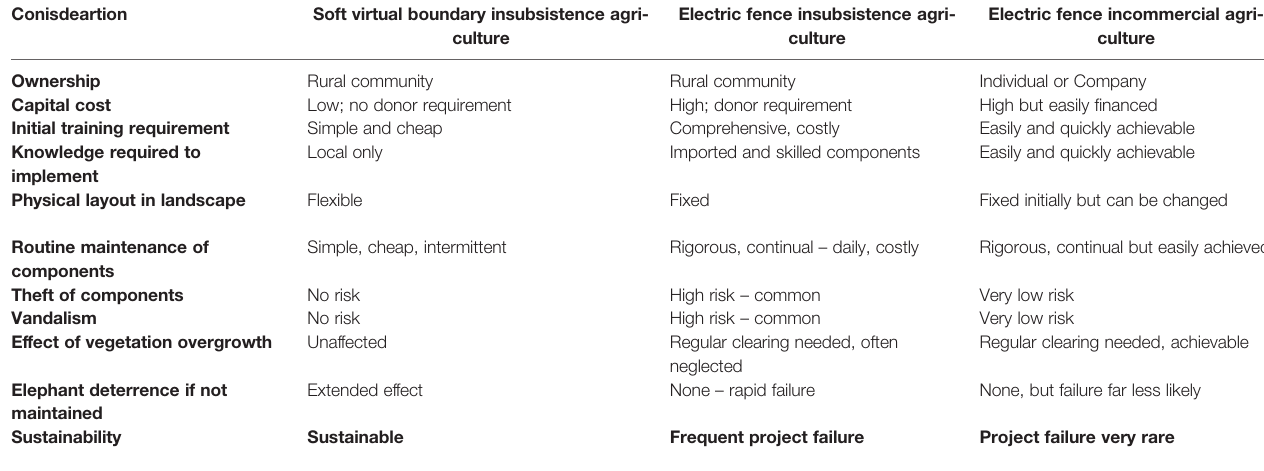
TABLE 3 | Comparative summary of considerations for human-elephant con fl ict mitigation in agriculture with a soft virtual boundary versus electric fencing.